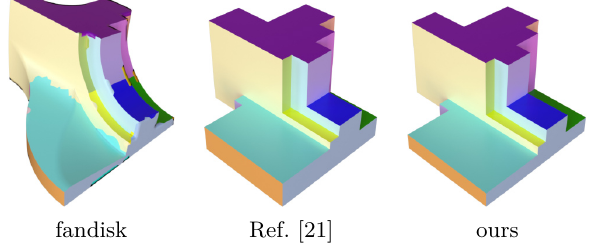
Fig. 9 Polycubes produced by the method in Ref. [21] and our method.